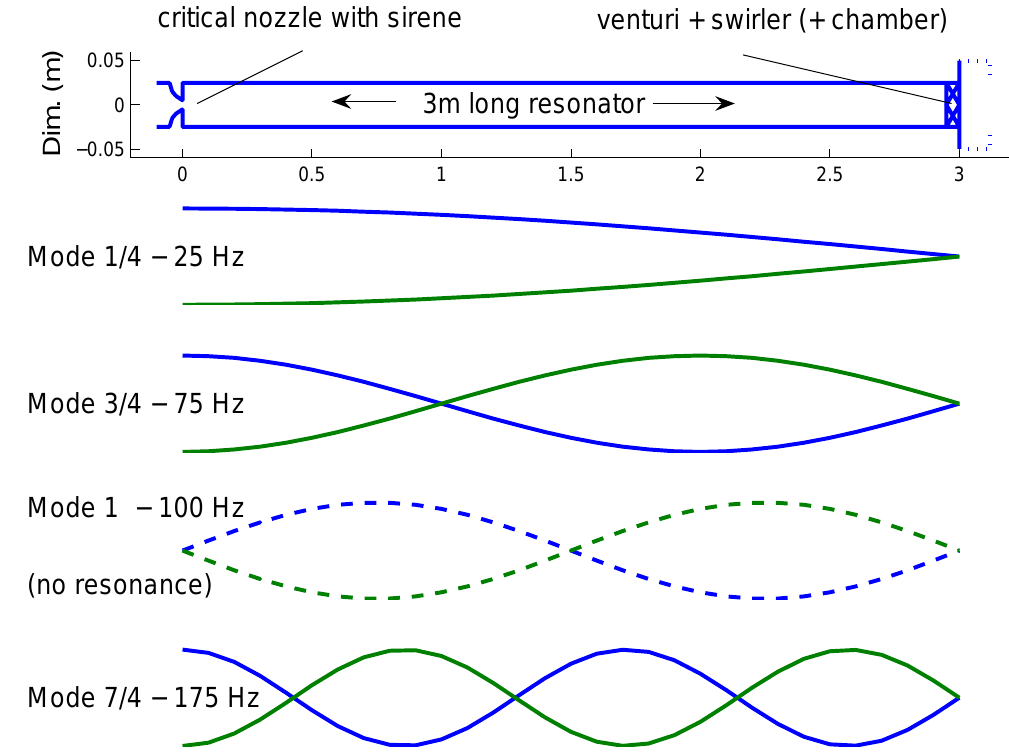
Figure 25. Amplified modes with the siren on a quarter-wave